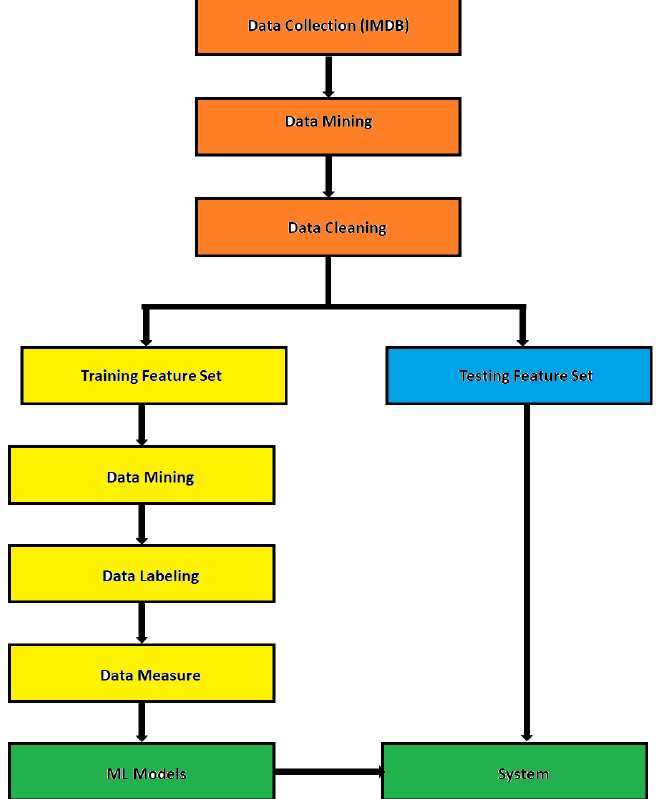
9 of 19 Table 5. Feature numerical representation. Feature